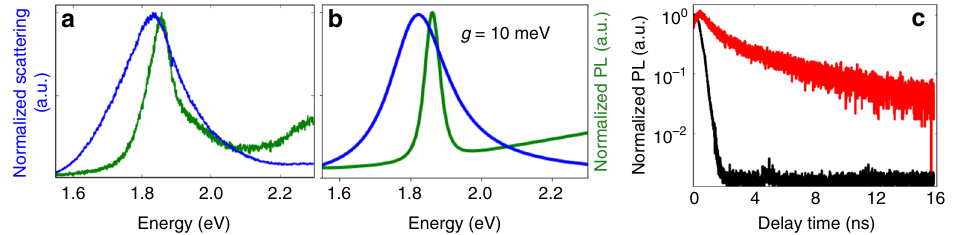
Fig. 3 Quantum-dot / gap-plasmon systems in the weak-coupling regime. a Measured scattering spectrum (blue) and photoluminescence spectrum (green). b Theoretical scattering and photoluminescence spectra. c Time-resolved photoluminescence from the coupled system (black), obtained by time- correlated single-photon counting. The red curve shows a reference trace obtained from isolated quantum dots